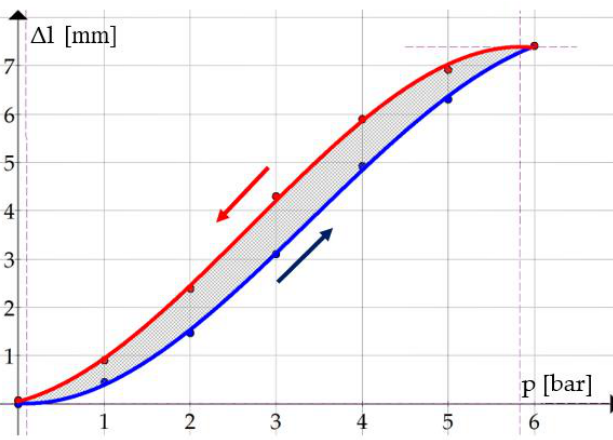
Figure 8. Evolution of the pneumatic muscle axial contraction versus air pressure.